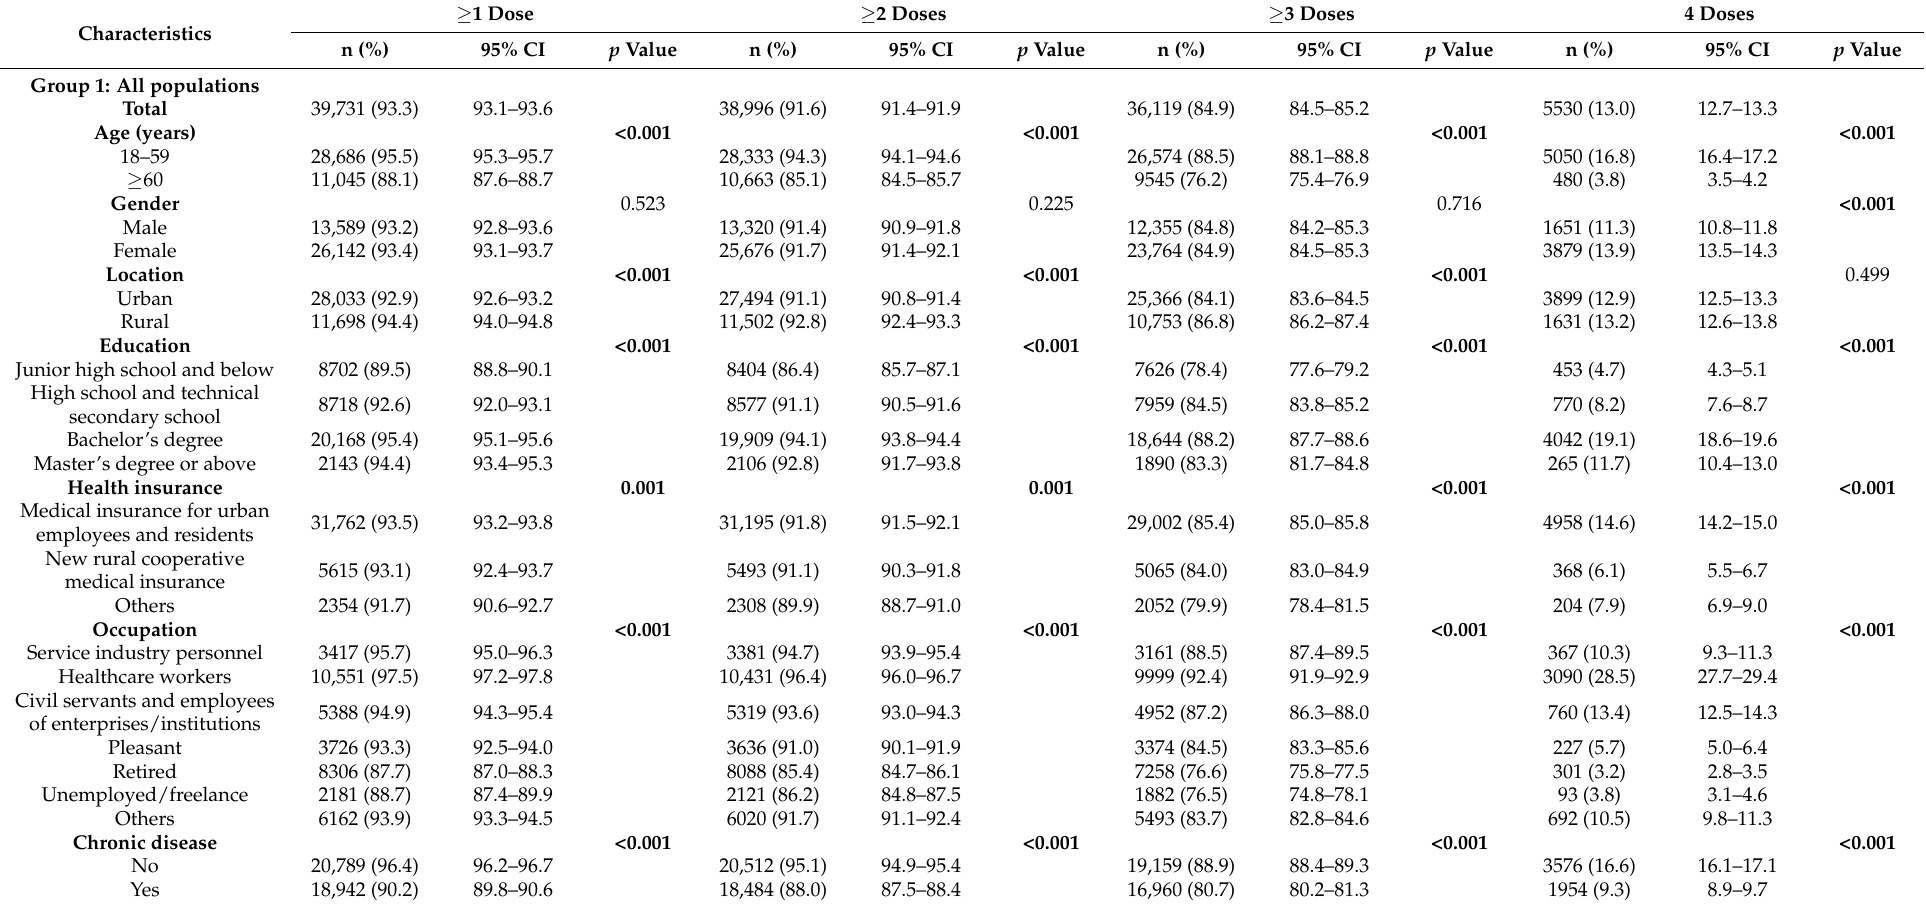
Table 2. COVID-19 vaccination coverage rates stratified by dose among all populations and people aged ≥ 60 years